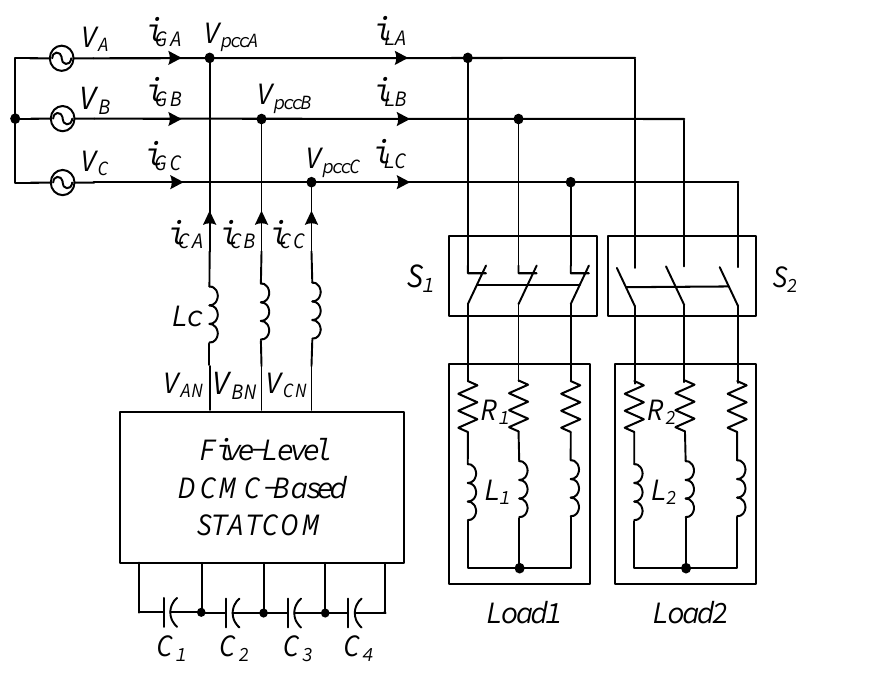
Figure 6. Simulation setup. Table 3. Parameters of the simulation system.